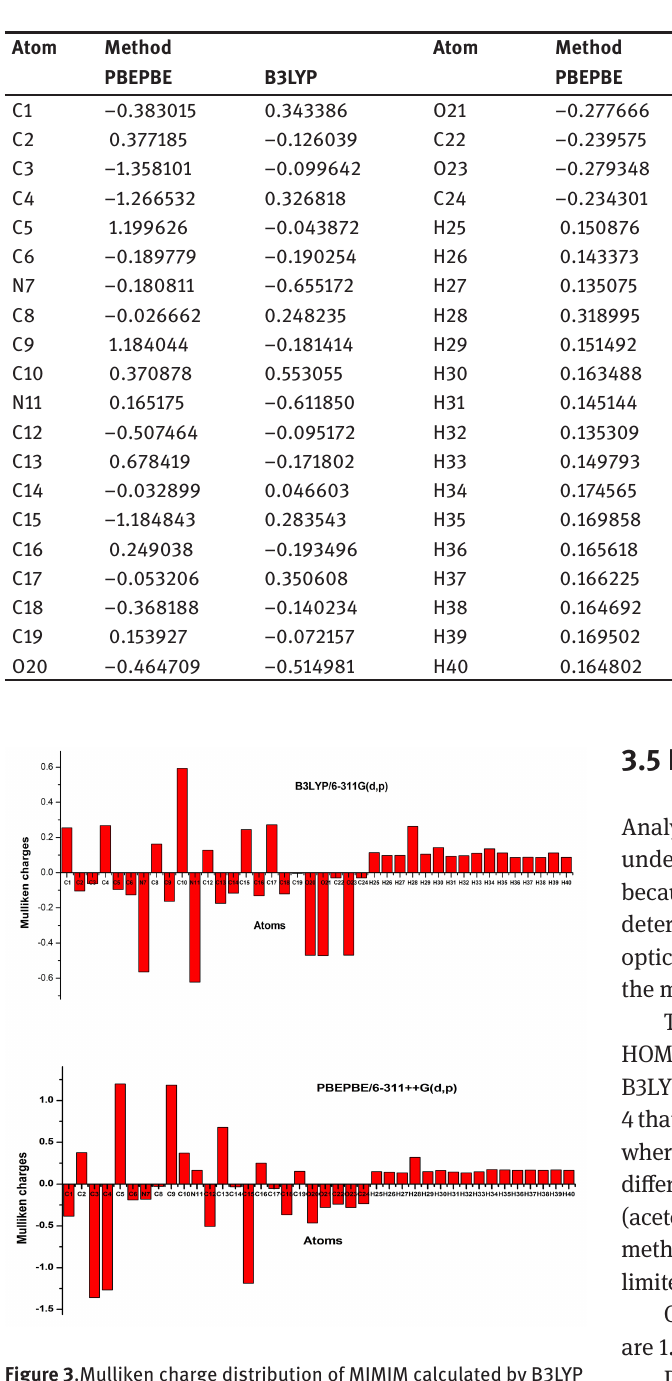
nitrogen atoms; little negative charge is also located on the methoxy carbons as well as the aromatic carbons C12 and C18. Conversely, positive charge is distributed over hydrogen atoms (charge = 0.14–0.17 by PBEPBE method and 0.08–0.28 by B3LYP method).